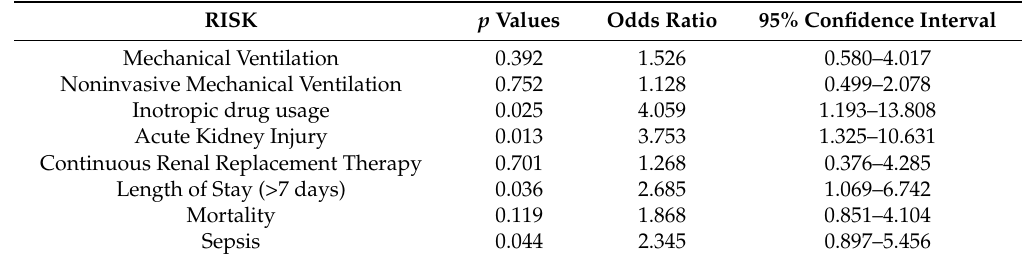
Table 5. Risk factors of patients with GGT > 40 IU (binary logistic regression models). RISK